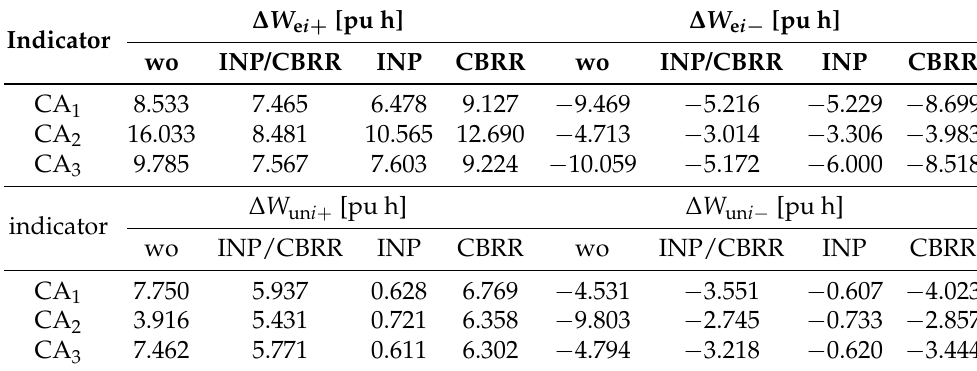
Table 4. Balancing energy and unintended exchange of energy.